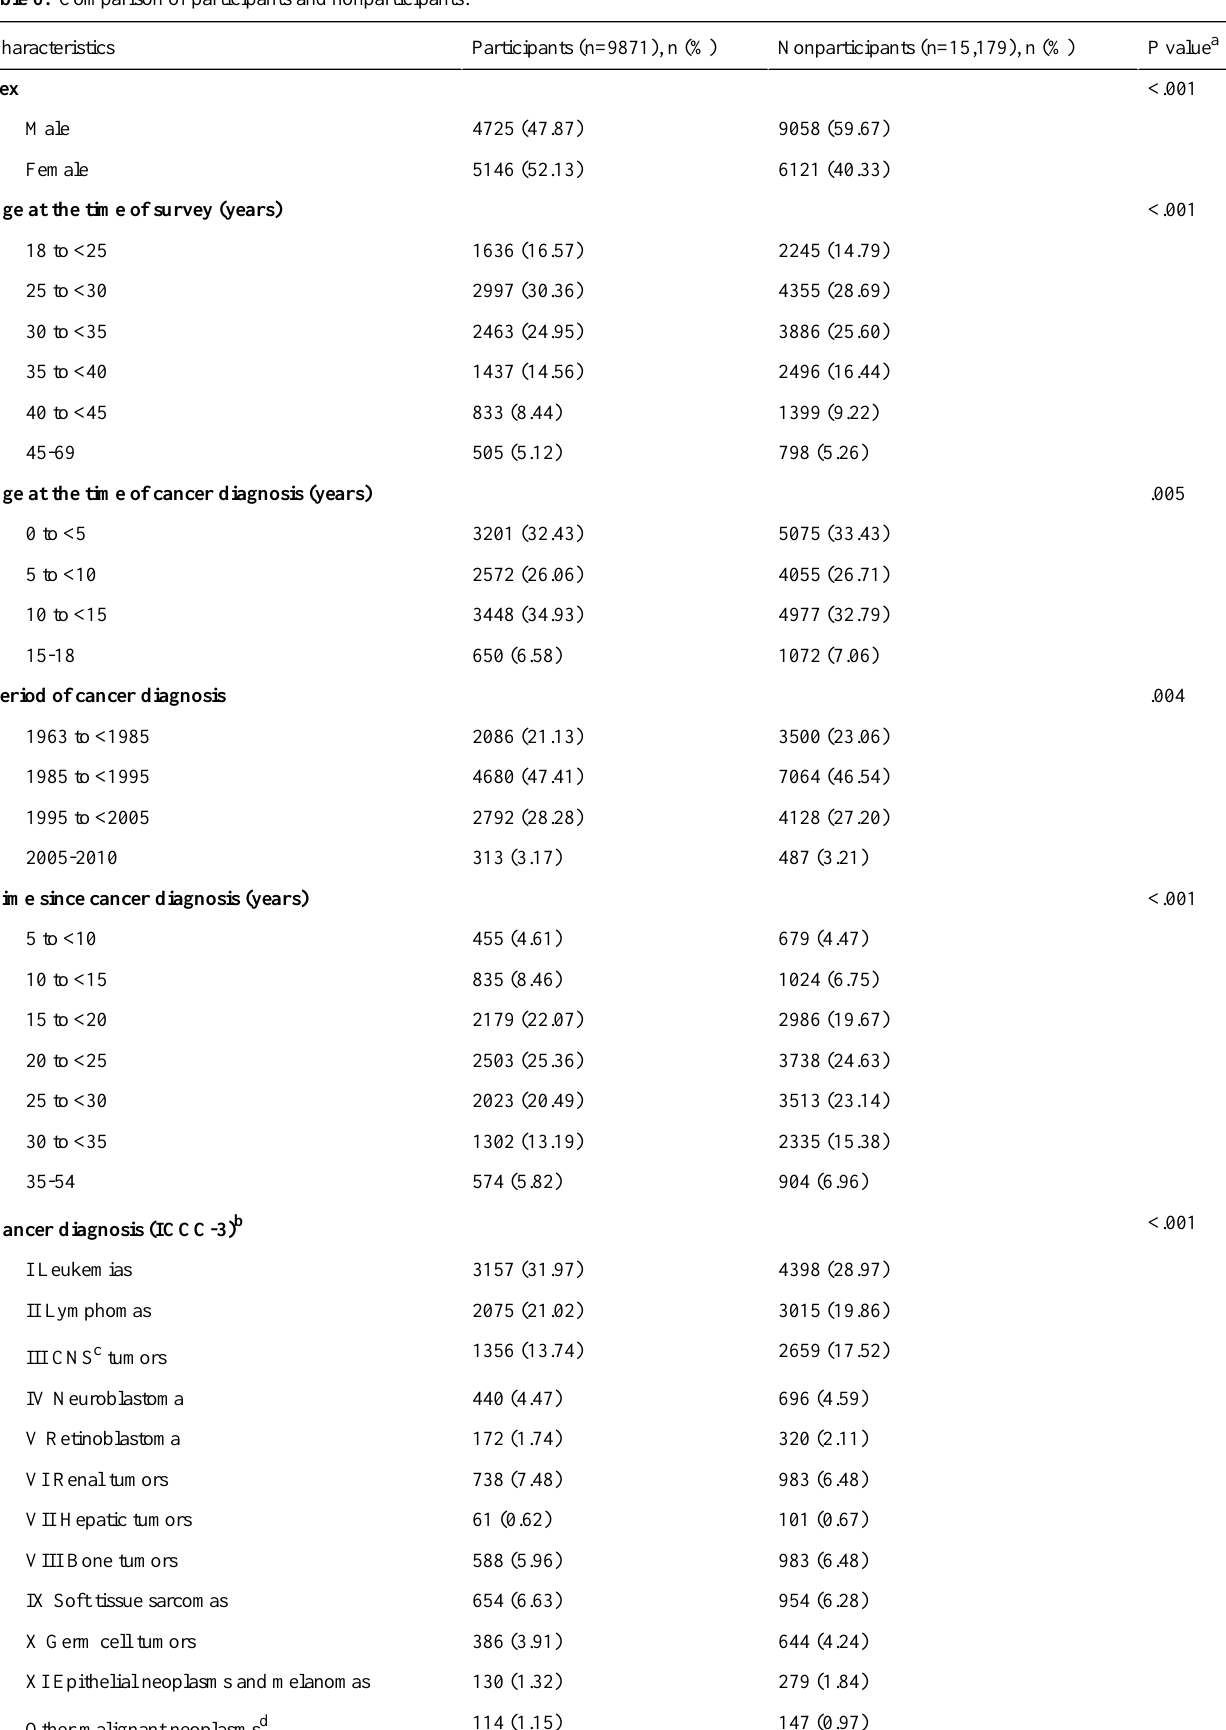
Table 6. Comparison of participants and